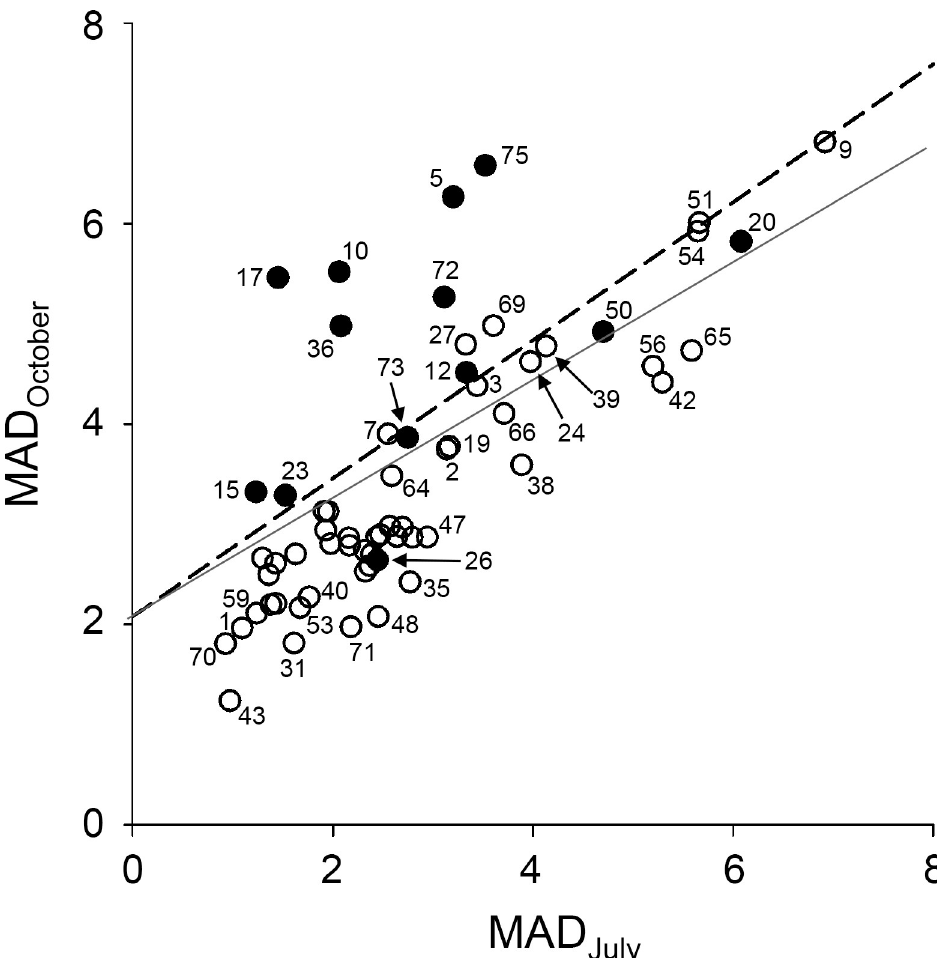
Fig 5. Classification of infected and uninfected trees by MAD values. Sample size: n = 13 for infected trees (closed dots); n = 50 for uninfected trees (open dots) for July and October in Gyeongju. Black dashed line: Separation line generated using linear discriminant analysis; gray line: Custom separation